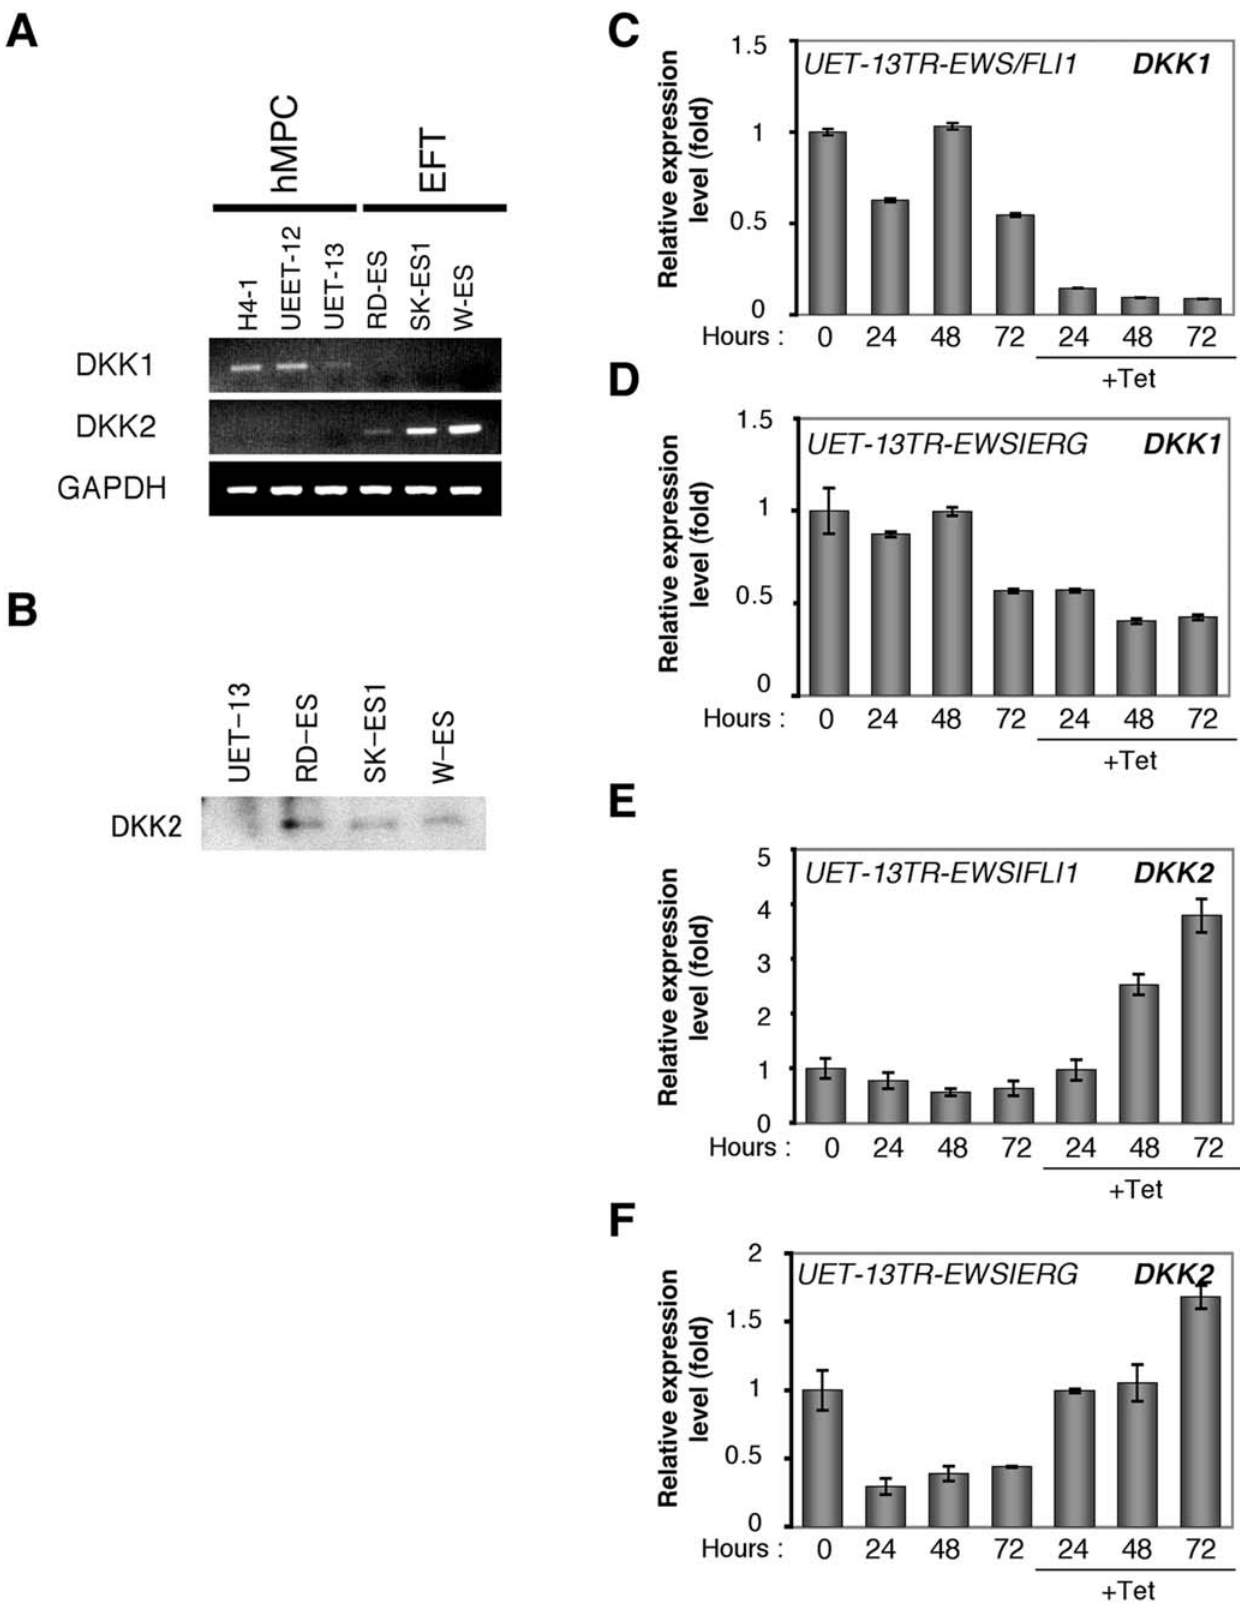
Figure 5. The change in expression pattern of the DKK family with EWS/ETS’s induction in UET-13 cells. A , The expression pattern of DKKs in hMPCs and EFT cells. DKK1 and DKK2 mRNAs in the H4-1, UEET-12, UET-13 and EFT cell lines were detected by RT-PCR. As an internal control, a human GAPDH gene was used. B , The expression of DKK2 protein in hMPCs and EFT cells. For the detection of secreted DKK2, cells were cultured PLoS ONE |